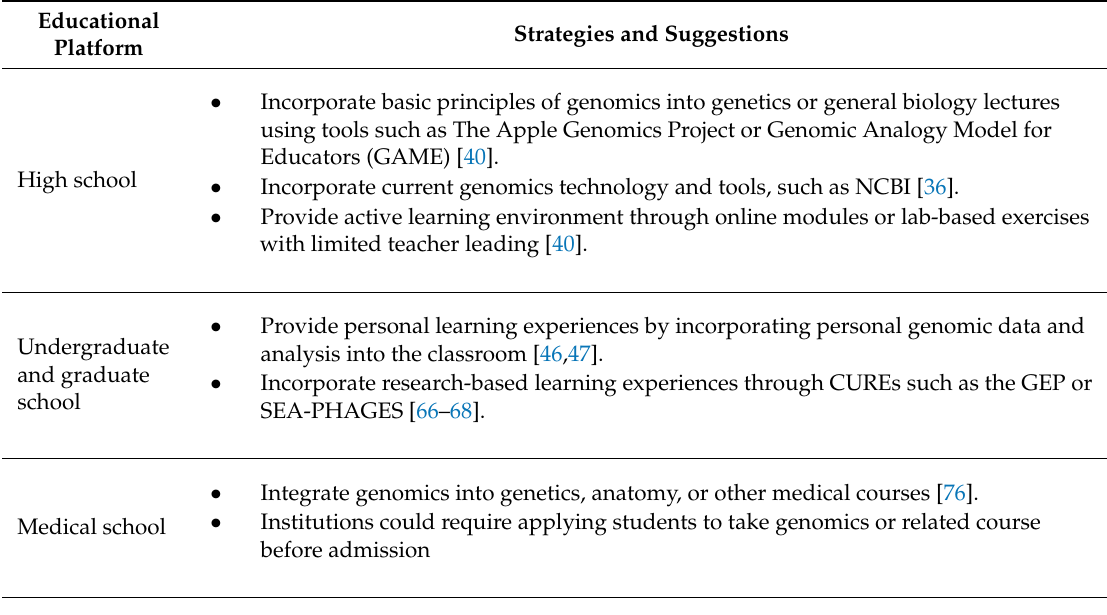
Strategies and suggestions for genomics education in academia, professional, and public